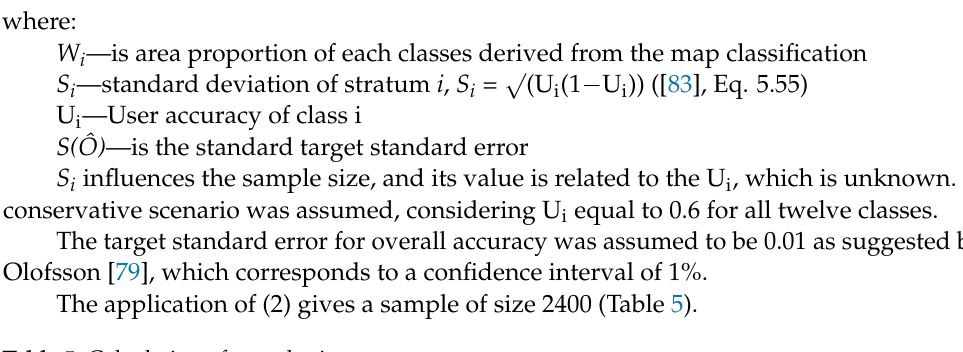
Table 5. Calculation of sample